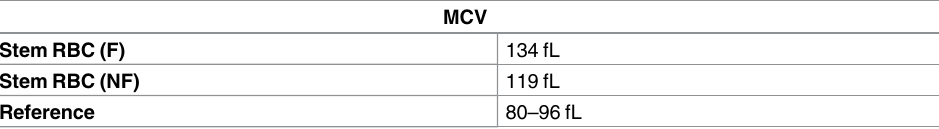
Table 1. Mean corpuscular volumes (MCV) of filtered (F) and non-filtered (NF) stemRBC and reference RBC values. MCV was determinedon Day 18 stemRBC using a Cell Dyne 3700 analyzer,(Abbott Diagnos- tics,